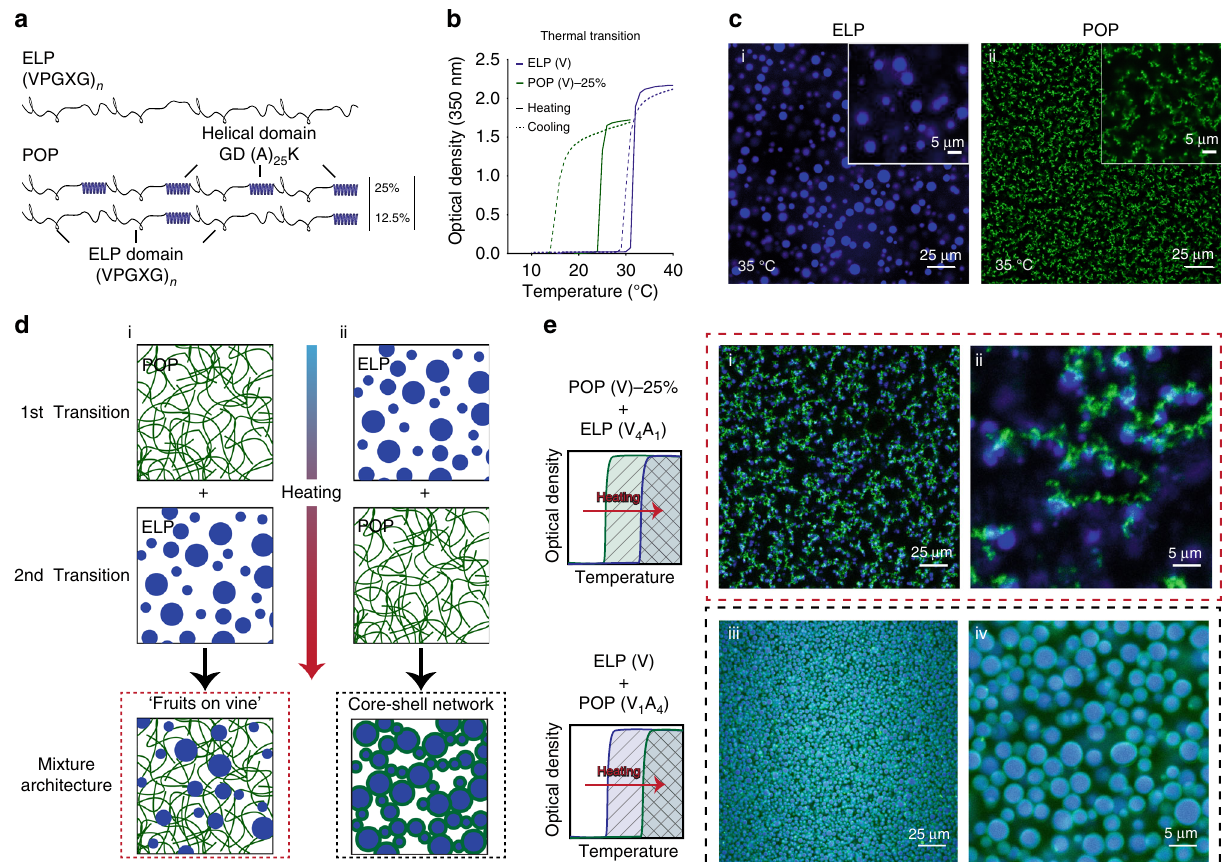
Fig. 1 Unusual IDP architectures through ELP-POP mixtures. a Sequence and architecture for ELPs and POPs. POPs have a disordered ELP backbone with ordered oligoalanine helices embedded at de fi ned intervals. b Cloud point temperatures ( T cp ) measured by optical turbidity for ELP(V) and POP(V)-25% (200 µ M, PBS). Both IDPs have sharp, LCST phase behavior, though POPs exhibit thermal hysteresis with a lower T cp -cooling than T cp -heating. c Single plane confocal microscopy images above the T cp s of (i) ELP(V) and (ii) POP(V)-25% (200 µ M, PBS). While ELPs form liquid-like coacervates above their T ‘ fruits-on-a-vine ’ and (ii) core-shell network cp , POPs form stable, physically crosslinked porous networks. d Schematic of the formation of the (i) architectures that form based on which component transitions at a lower temperature. e Single plane confocal images of (i – ii) mixtures of POP(V)-25% (200 µ M) + ELP(V 4 A 1 ) (200 µ M) depicting the ‘ fruits-on-a-vine ’ architecture and (iii-iv) mixtures of ELP(V) (500 µ M) + POP(V 1 A 4 )-25% (100 µ